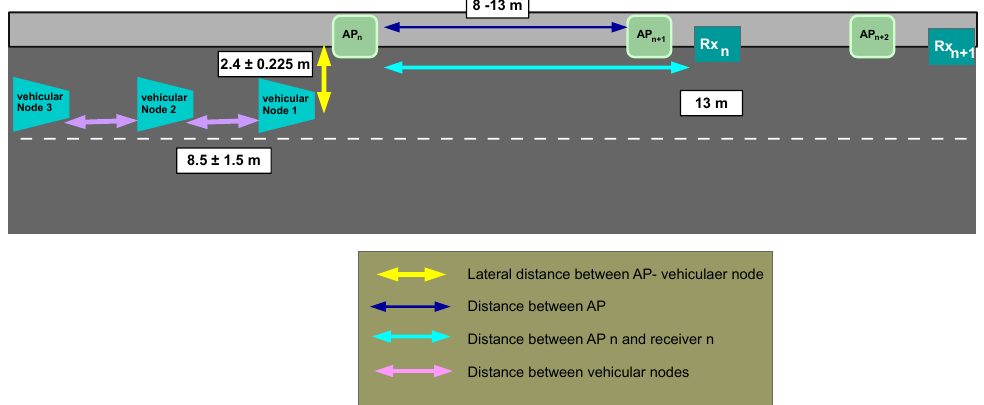
Figure 14. Scenario 2: Graphical representation of the VLC network with multiple vehicular